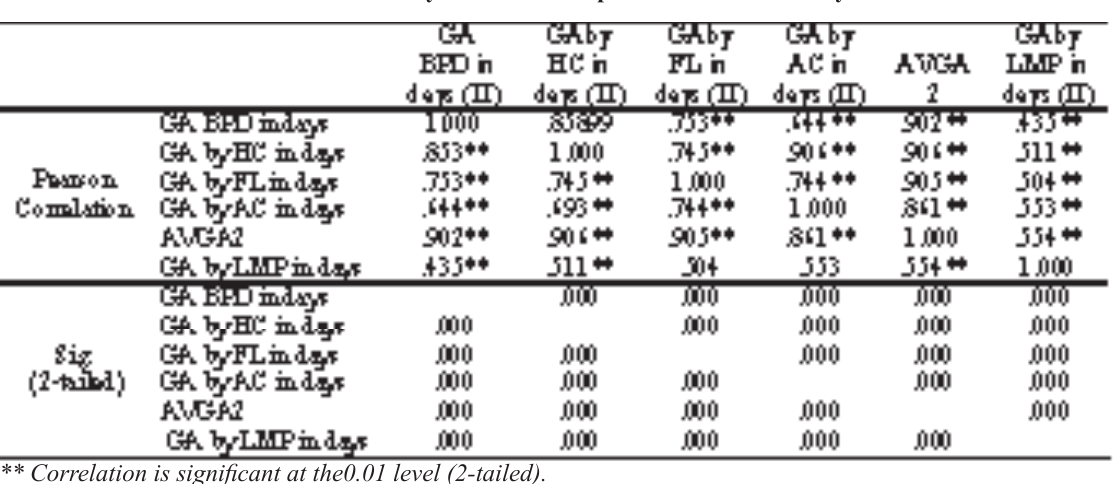
Table III: Pearson correlation of GA by different fetal parameters with GA by LMP in 3 rd Trimester